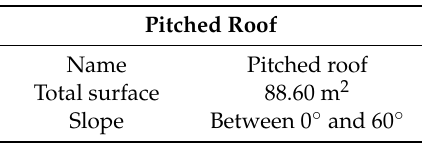
Table 9. Extracted data of pitched roof out of the EPC.